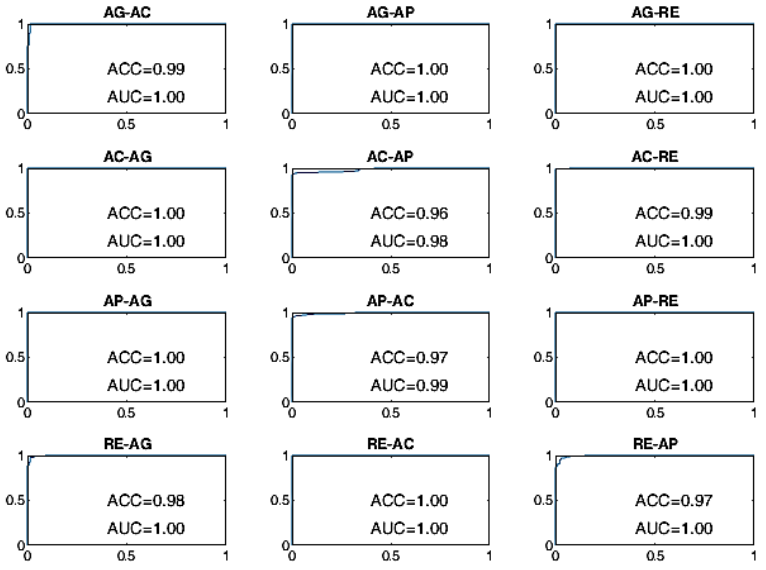
Figure 12. ROC curves of the BLSTM-AE TCN approach on the DS1 dataset for WD = 15 s.